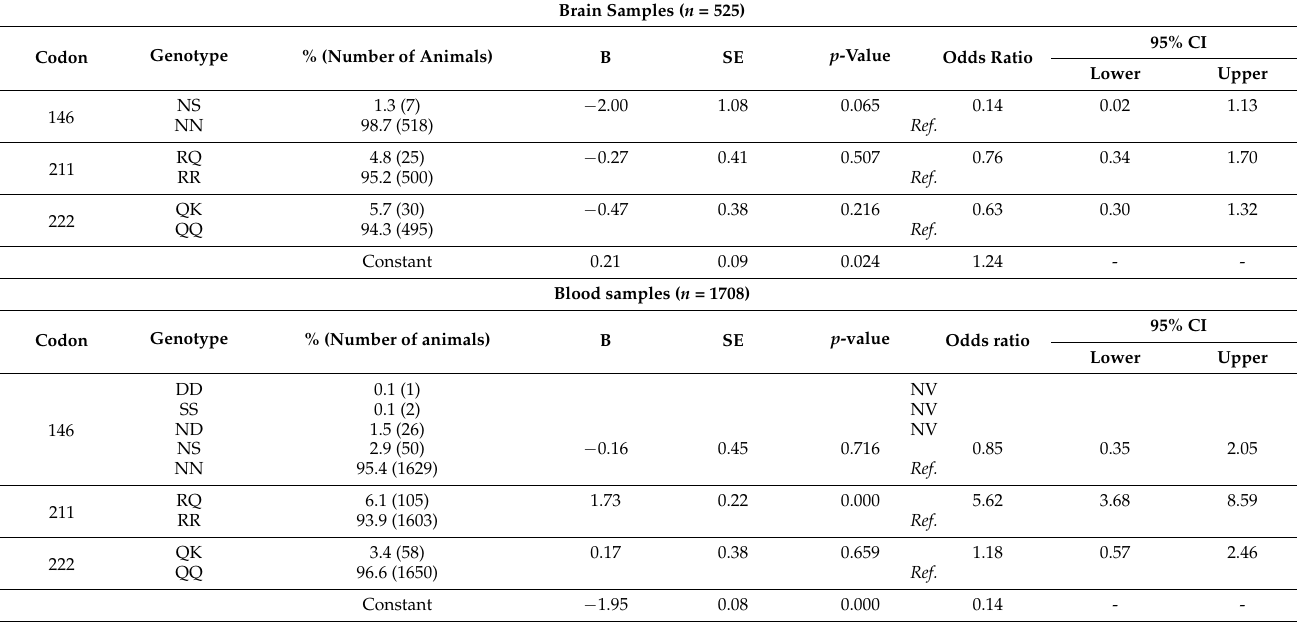
Table 3. Genotypic frequencies (%) and corresponding number of animals (in parenthesis) for codons 146, 211, and 222 of the PRNP gene, as well as the effects of the observed genotypes (i) on individual goat scrapie-status (brain samples), and (ii) on the herd scrapie-status (blood